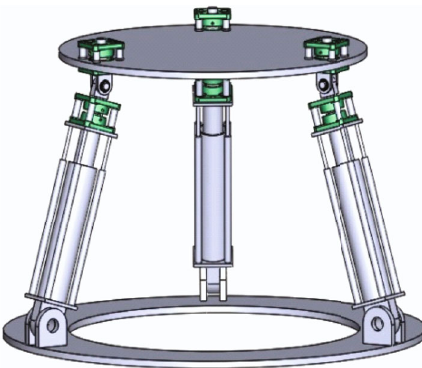
Figure 20: Con fi guration of the self-adaptive levelling